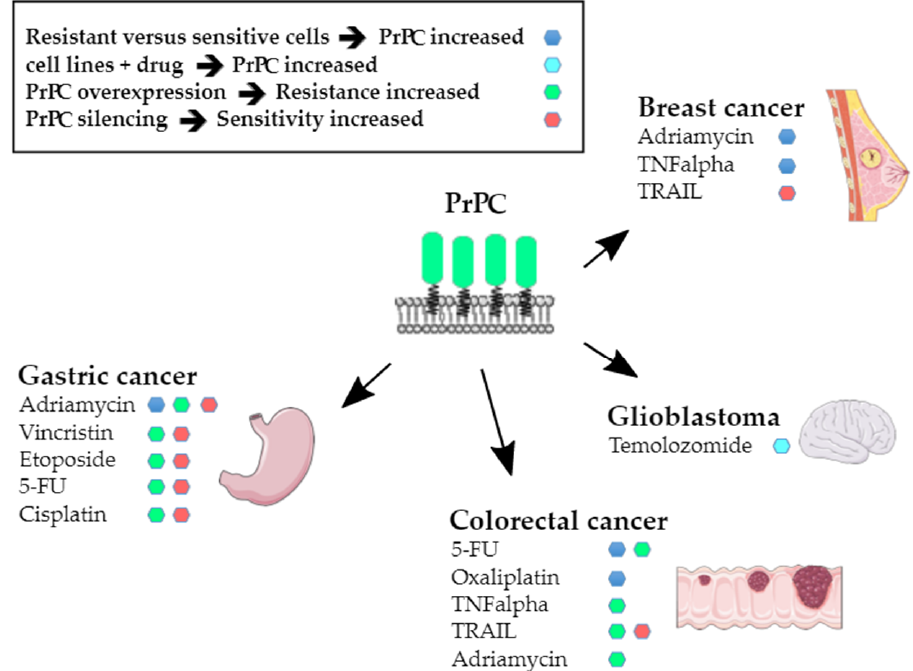
Figure 2. Summary of the data supporting a link between PrP C expression and resistance to cytotoxic agents.